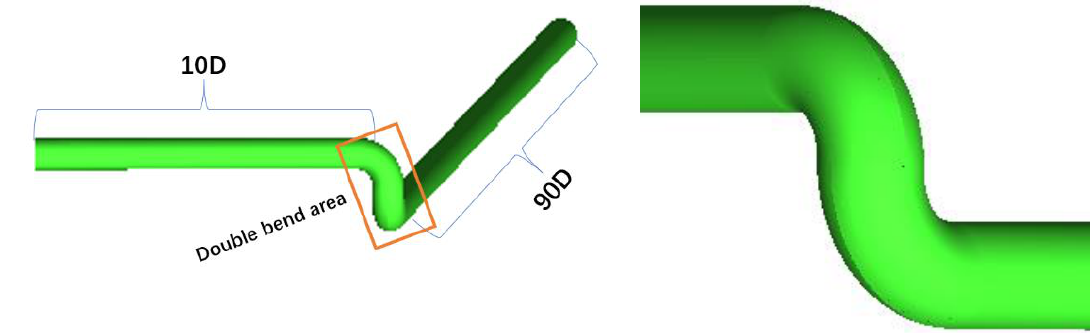
Figure 2. Global and local views of geometric model.